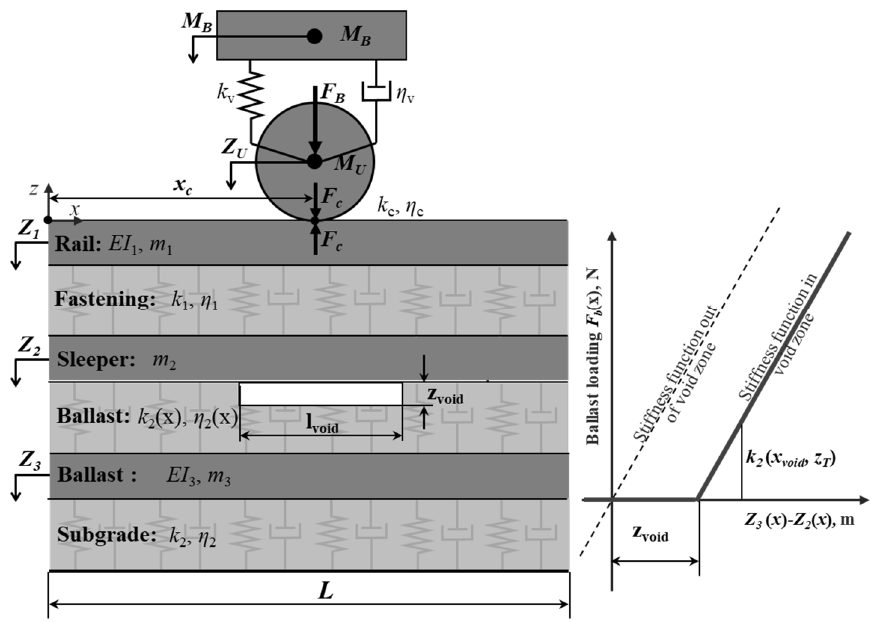
Figure 3. Three-beam model of track and rolling stock interaction.